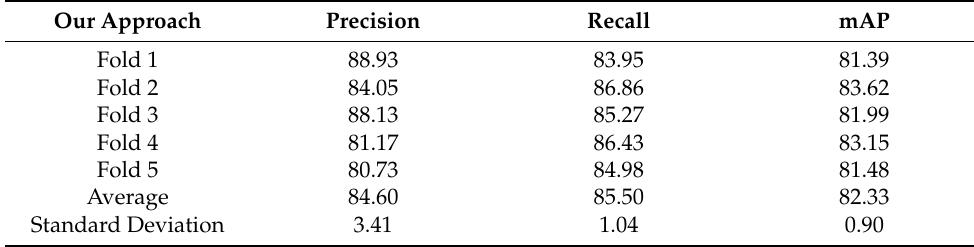
Table 5. Results of 5-fold cross-validation from Our